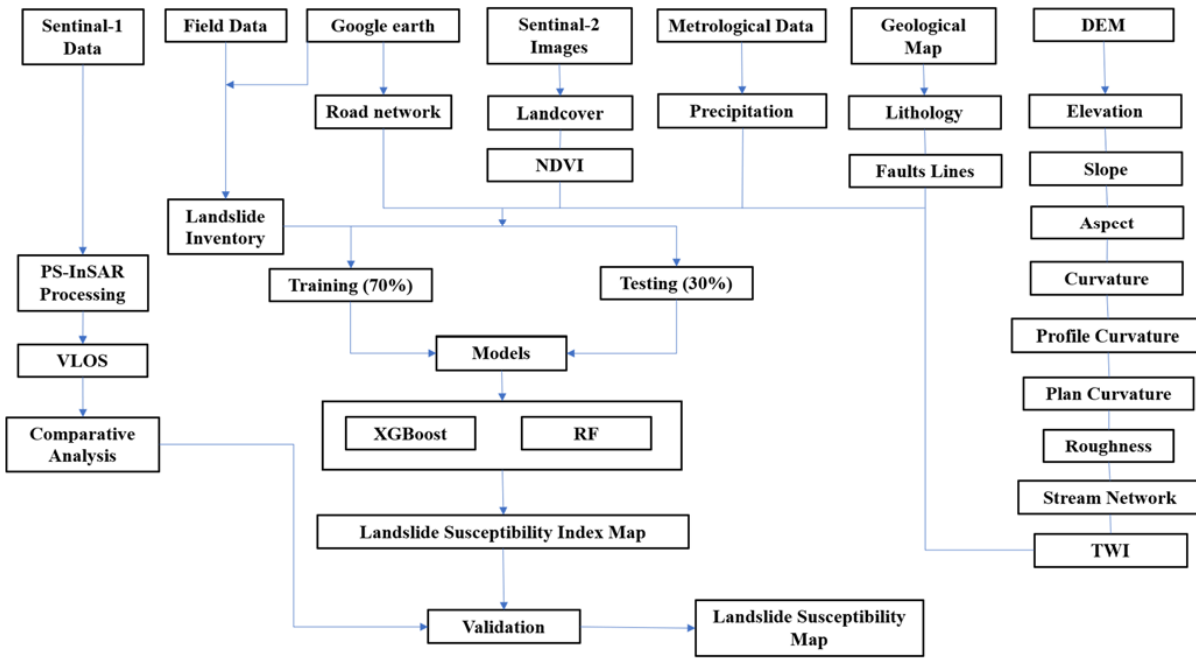
Figure 3. Workflow of the research .